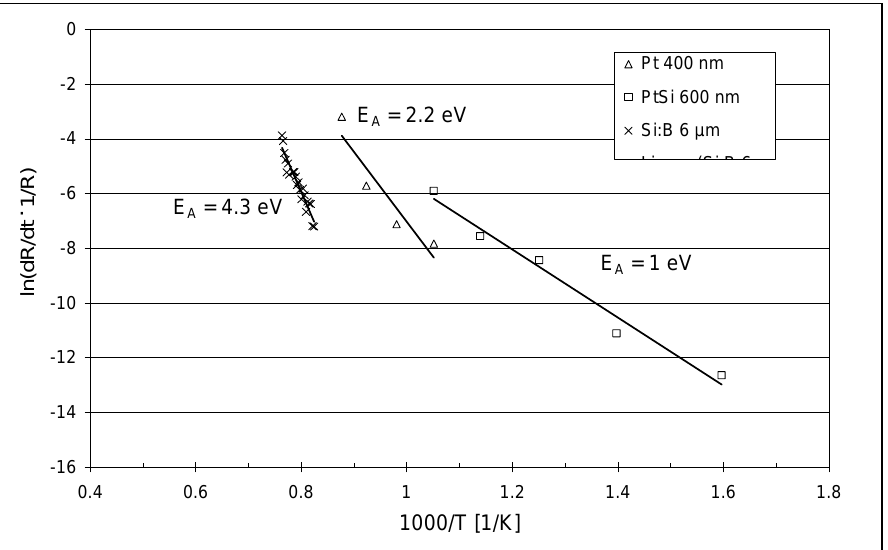
Figure 7. Activation energy for heater degradation for different heater materials. Si:B heaters are seen to perform considerably better at high temperature than metallic ones. SnO larger activation energies. Because of a residual gas sensing effect, reliable values of E obtained in this latter